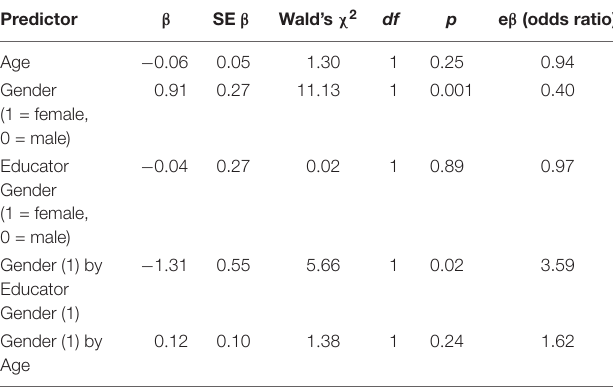
TABLE 1 | Logistic regression analysis of children’s male-biased math stereotype awareness